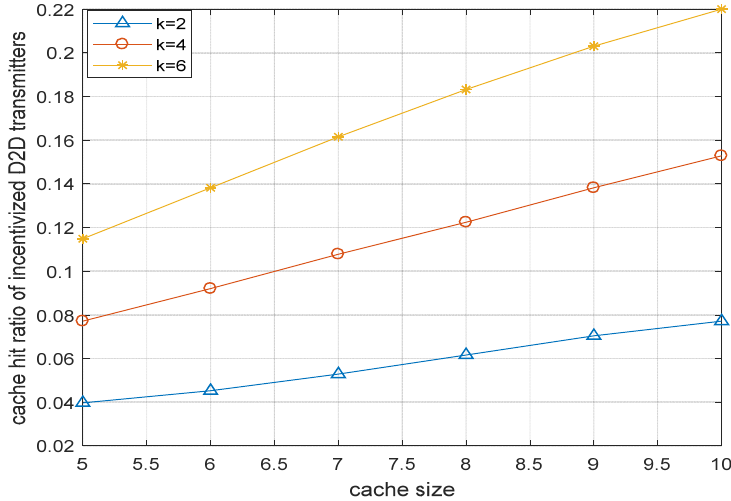
Figure 8. Cache hit ratio vs. cache size of incentivized D2D transmitters.